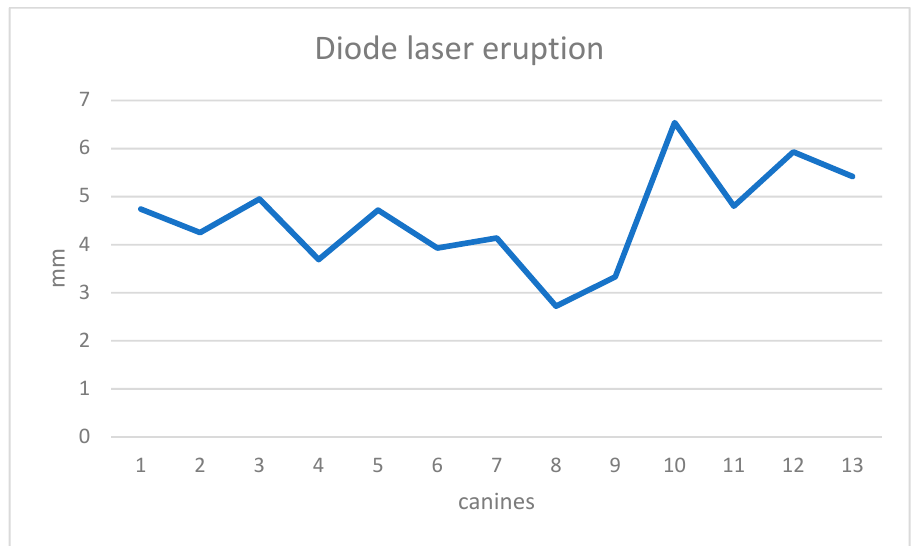
Figure 8. Values of eruption of the 13 canines at 16 weeks after laser surgery. The speed of eruption was also considered for each canine. The eruption of the canines occurred with a mean speed of 0.045 mm/day. It was found that the mean speed in